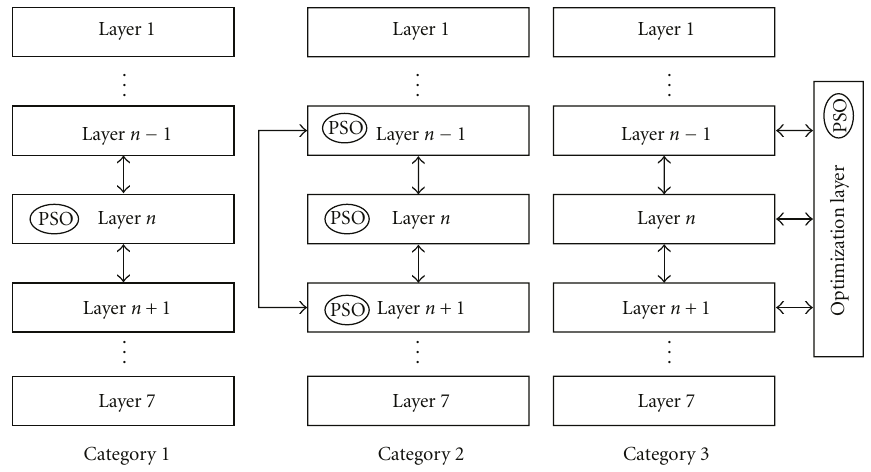
Figure 2: Centralized PSO for cross-layer optimization scenarios in a single node.